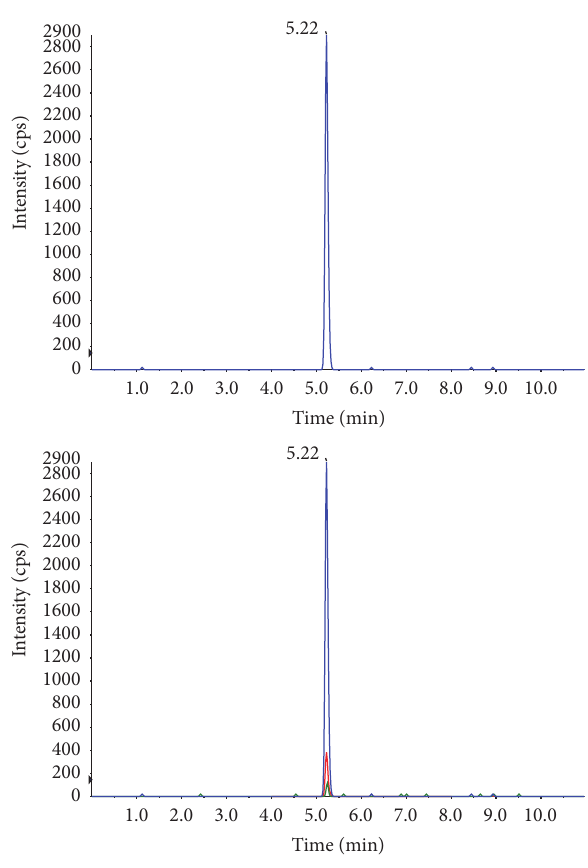
Figure 1: Chromatograms of sulfadimethoxine and fragments generated at concentration of 6.25 𝜇 g L −1 , Botucatu/SP,